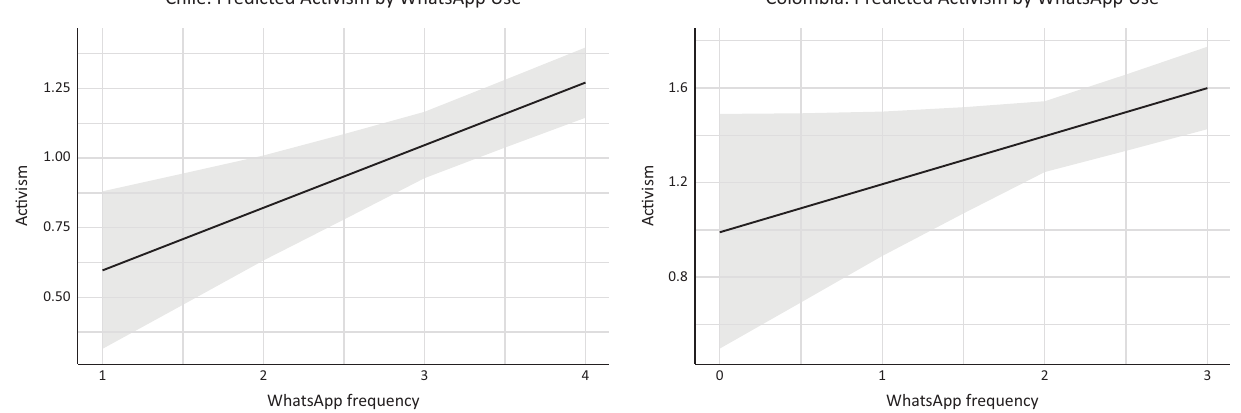
Figure 4. Predicted values of non‐conventional political participation according to WhatsApp usage frequency.